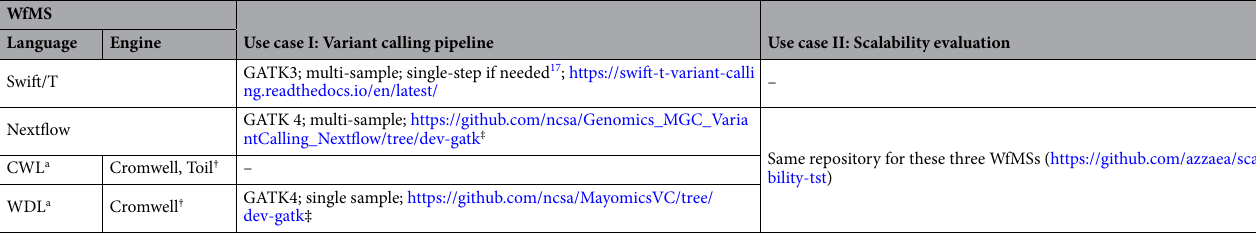
Table 4. The WfMSs examined in this study. † Other engines were limited in portability, conformance to language specification, or setup (Table 2). ‡ Repositories with identical code structure, which facilitated comparison of results (Supplementary note 1). a Common Workflow Languagen (CWL); Workflow Description Language